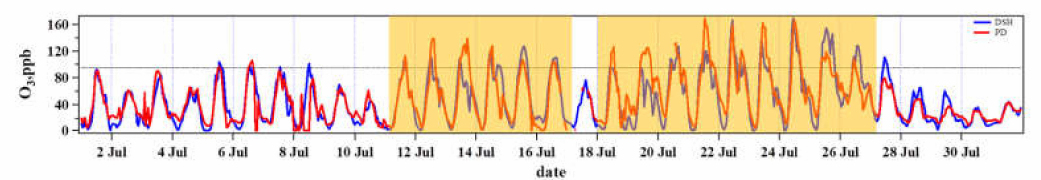
Figure 2. Time series of the hourly average O 3 concentrations at the DSH (blue line) and PD (red line) sites from 1–31 July 2017. The horizontal black dotted line means the national grade II standard for daily maximum 1-h moving average (DMA-1h) O 3 (200 µ g / m 3 , i.e., 93.3 ppbV). The areas shaded by orange represent two O 3 pollution episodes (11–16 and 18–26